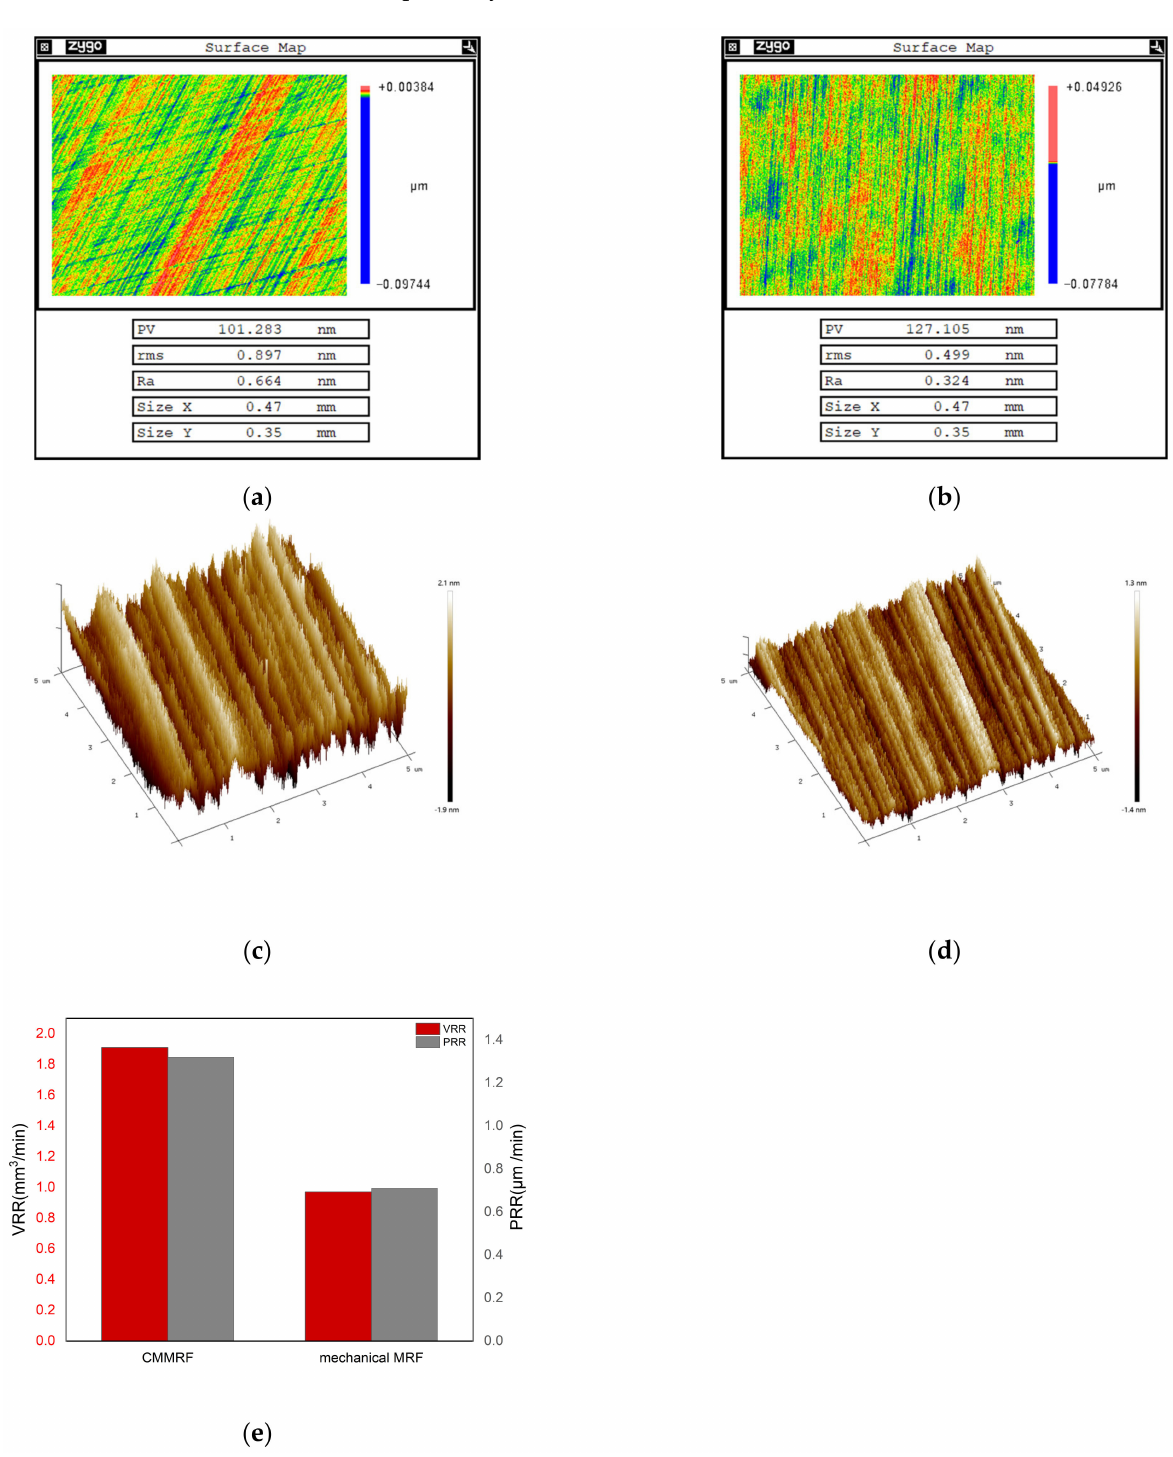
Figure 5. Polishing results of different MRF fluid:( a ) Surface roughness after mechanical MRF process (measured by WLI); ( b ) surface roughness after CMMRF process (measured by WLI); ( c ) surface roughness after mechanical MRF process (measured by AFM); ( d ) surface roughness after CMMRF process (measured by AFM); ( e ) comparison of material removal rate of mechanical MRF and